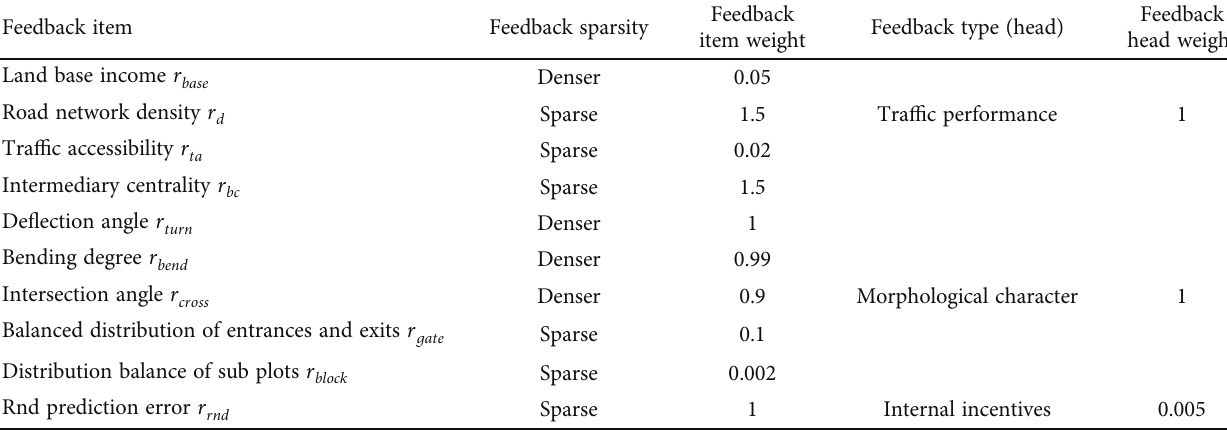
Table 3: Feedback structure of urban land network generation problems.